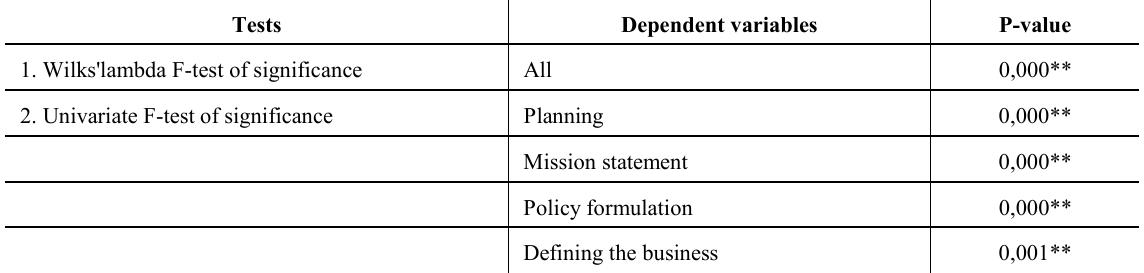
Table 1: The results of the tests to investigate the relationships between power culture and strategy